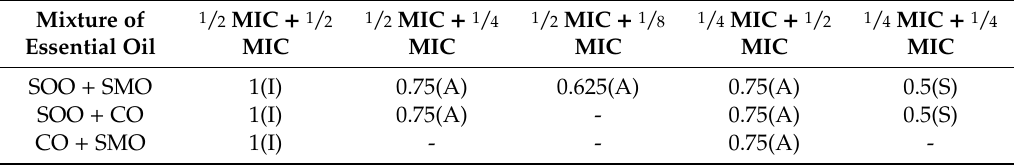
Table 3. Fractional inhibitory concentration index (FICI) values and interactions between combinations of essential oils.